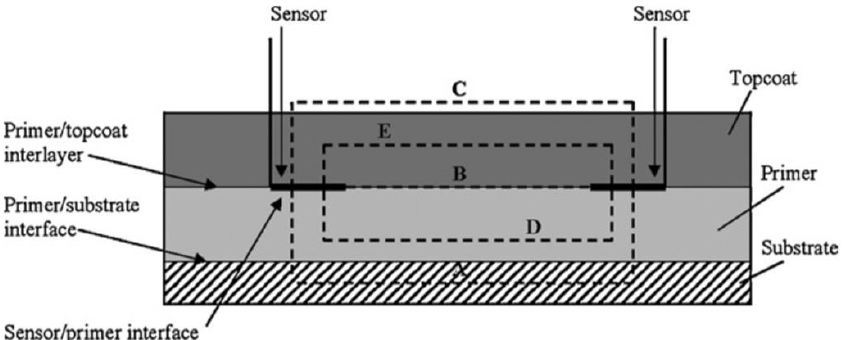
Figure 9. The schematics of a non-substrate two-electrode EIS measurement between two embedded electrodes and the five possible current flow pathways at low frequency, where, according to au- thors, “Path A involves passing through the electrode/coating interface, the base coating and the coating/substrate interface for each electrode and passing through the metal. Path B involves passing between the electrodes through the top coat/primer interlayer. Path C involves passage through the electrode/coating interface, the top coat of each electrode and passage through the electrolyte on the surface of the coating. Path D involves passage through the electrode/primer interface and through the primer, while Path E involves passage through the electrode/topcoat interface and through the topcoat”. Reprinted with permission from ref. [82], Elsevier,